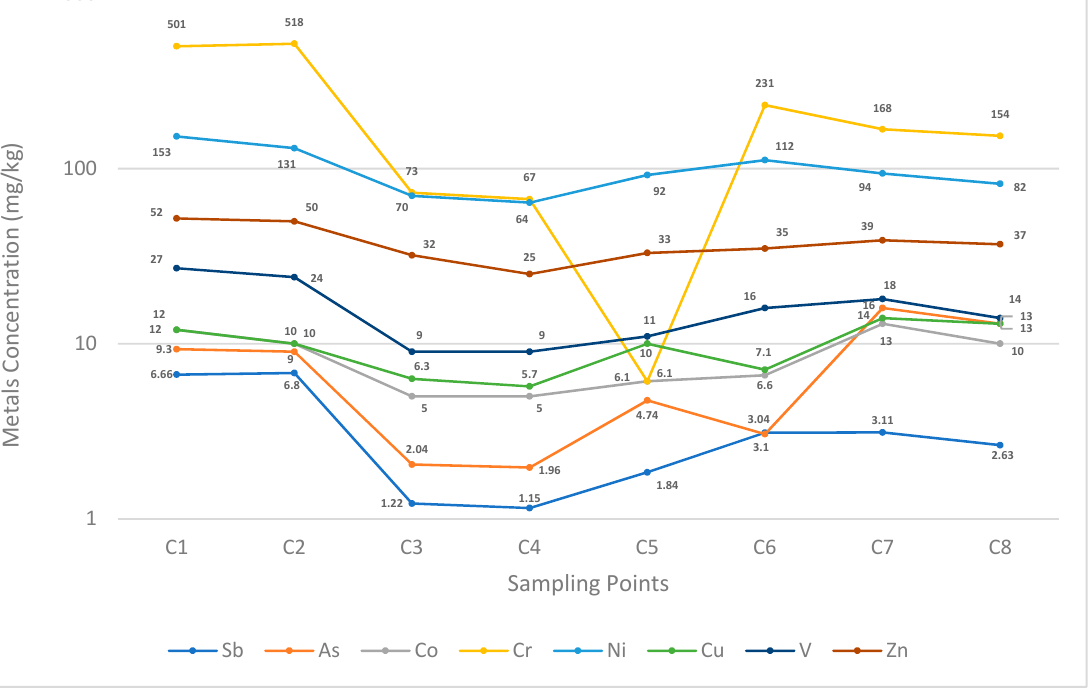
Figure 6. Concentrations of each metal in each sampling point. (Sb ± 0.75; As ± 1.1; Co ± 2.3; Cr ± 4.1; Ni ± 11; Cu ± 1.9; V ± Zn ± 6.2).